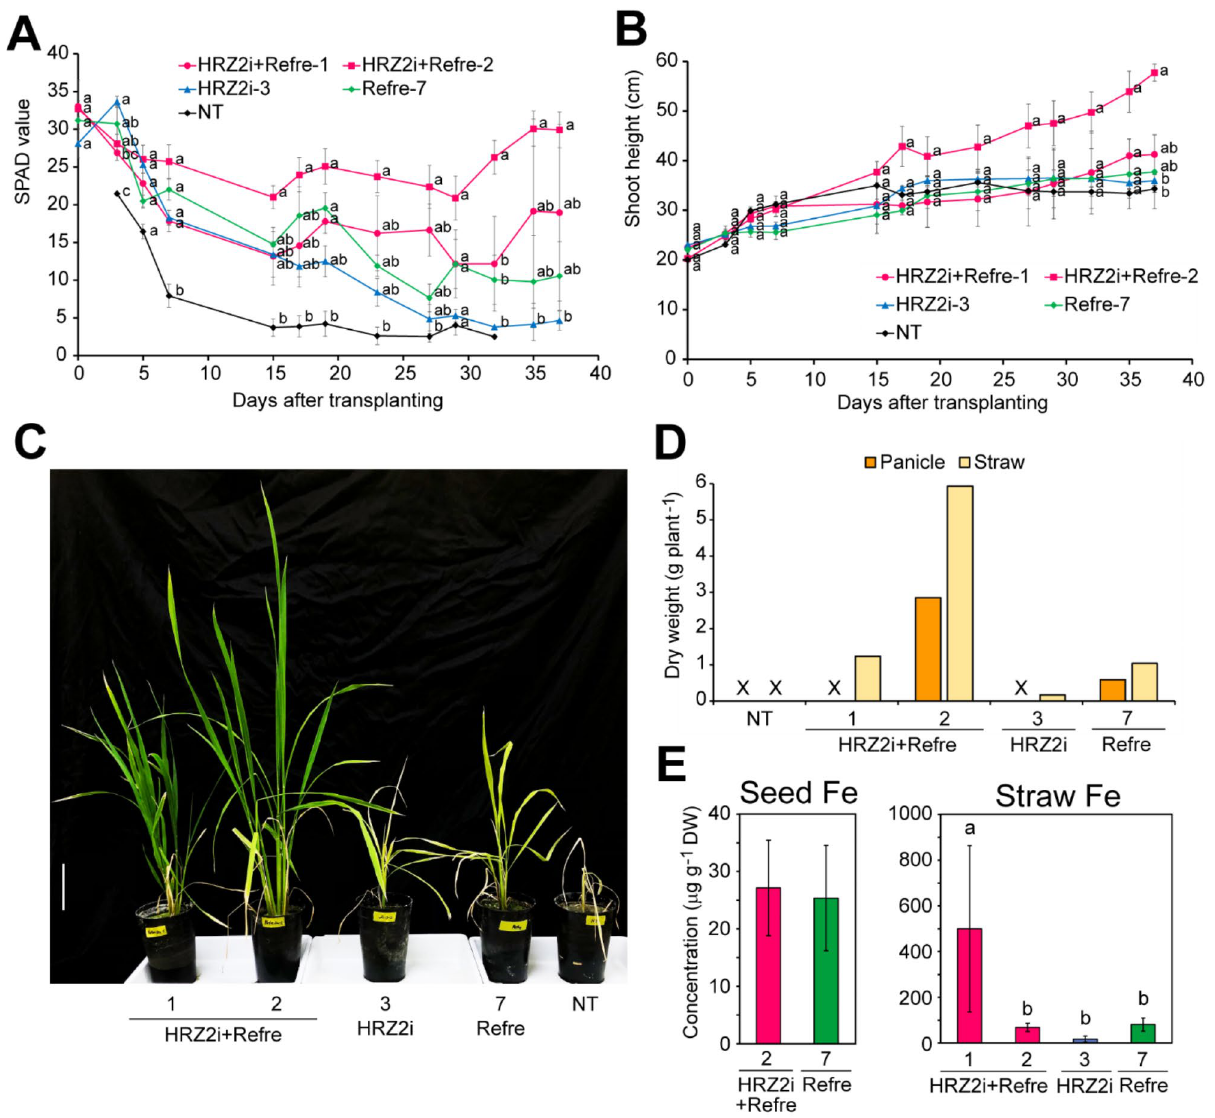
Fig. 4 Features of the HRZ2i + Refre lines compared with single transformation lines in non-submerged calcareous soil. A SPAD value of the newest leaves. Data for NT on day 0 were around 30 but not recorded; data for NT on days 35 and 37 were unavailable due to the death of all new leaves. B Shoot height. C Representative plants on the 59th day after transplanting. Scale bar = 10 cm. D Panicle and straw dry weights after seed maturation. All the surviving plants were collected. An “X” mark indicates no yield. E Fe concentrations in the brown seeds and straw following seed maturation. The following lines were cultivated: NT, non-transformants; HRZ2i + Refre, T 1 lines of 1 and 2; HRZ2i, T 2 line 3; Refre, T 3 line 7. DW: dry weight. For A and B , means ± SE are shown (n = 10 for HRZ2i + Refre line 2; n = 5 for other lines). For E , means ± SD are shown (n = 6 for HRZ2i + Refre line 2 for seed Fe; n = 3 for Refre line 7 for seed Fe; n = 7 for HRZ2i + Refre line 2 for straw Fe; n = 4 for other lines for straw Fe). Different letters indicate significant differences ( P < 0.05; Tukey’s honest significant difference test). Datum for NT on day 32 was not used for this test due to the death of all new leaves except for one